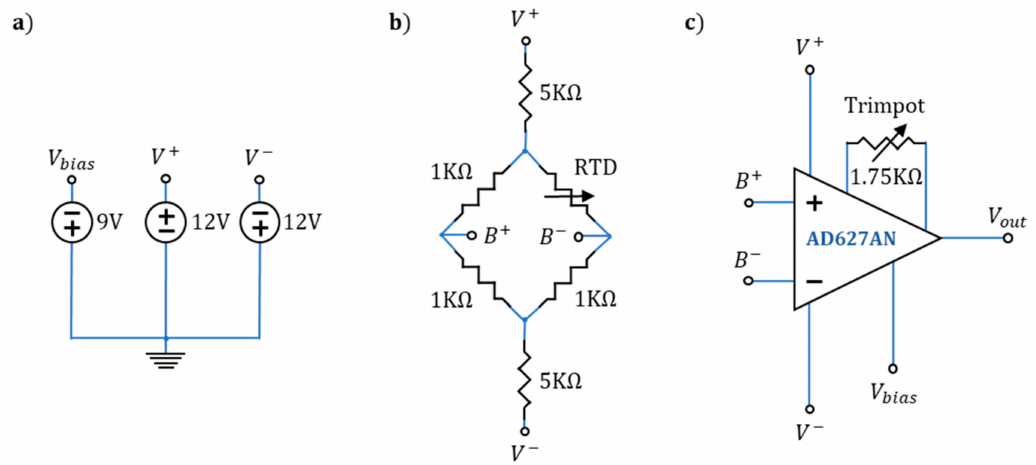
Figure 3. Resistance temperature detector (RTD) sensing circuit ( a ), power source configuration for the Wheatstone bridge and signal conditioning of the RTD signal where V + , V − and V bias represents a physical point of connection to 12 V, –12 V and 9 V respectively; ( b ), Wheatstone bridge configuration for the two wire RTDs. The circuit is excited by the two voltage sources at V + and V − . A change on the RTD nominal value creates a voltage di ff erence between B + and B − ; ( c ), instrumentation amplifier circuit, the AD627AN amplifies and shifts the value of the di ff erential voltage between B + and B − and outputs a ground referenced voltage V out that is connected to a data acquisition card (Labjack U12) for